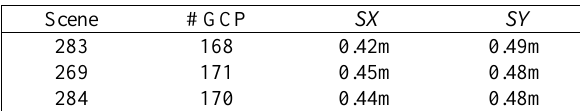
Table 3. Summary of root mean square differences at